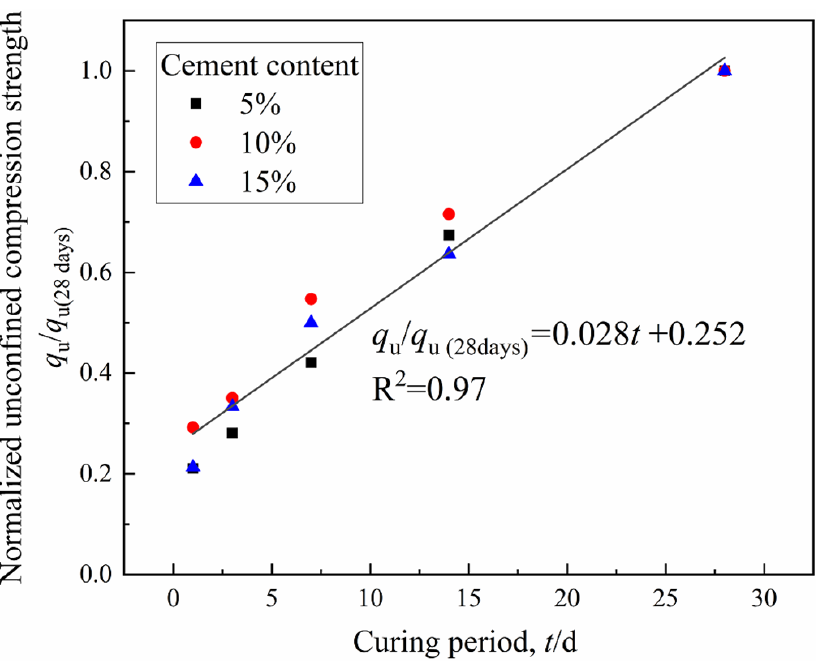
Figure 13. Variation of normalized strength with curing period.